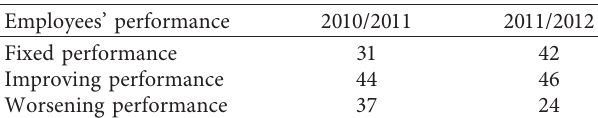
Table 6: Performance story of the employees (real data). Number of employees which changes or does not change their performance during years 2010/2011 and